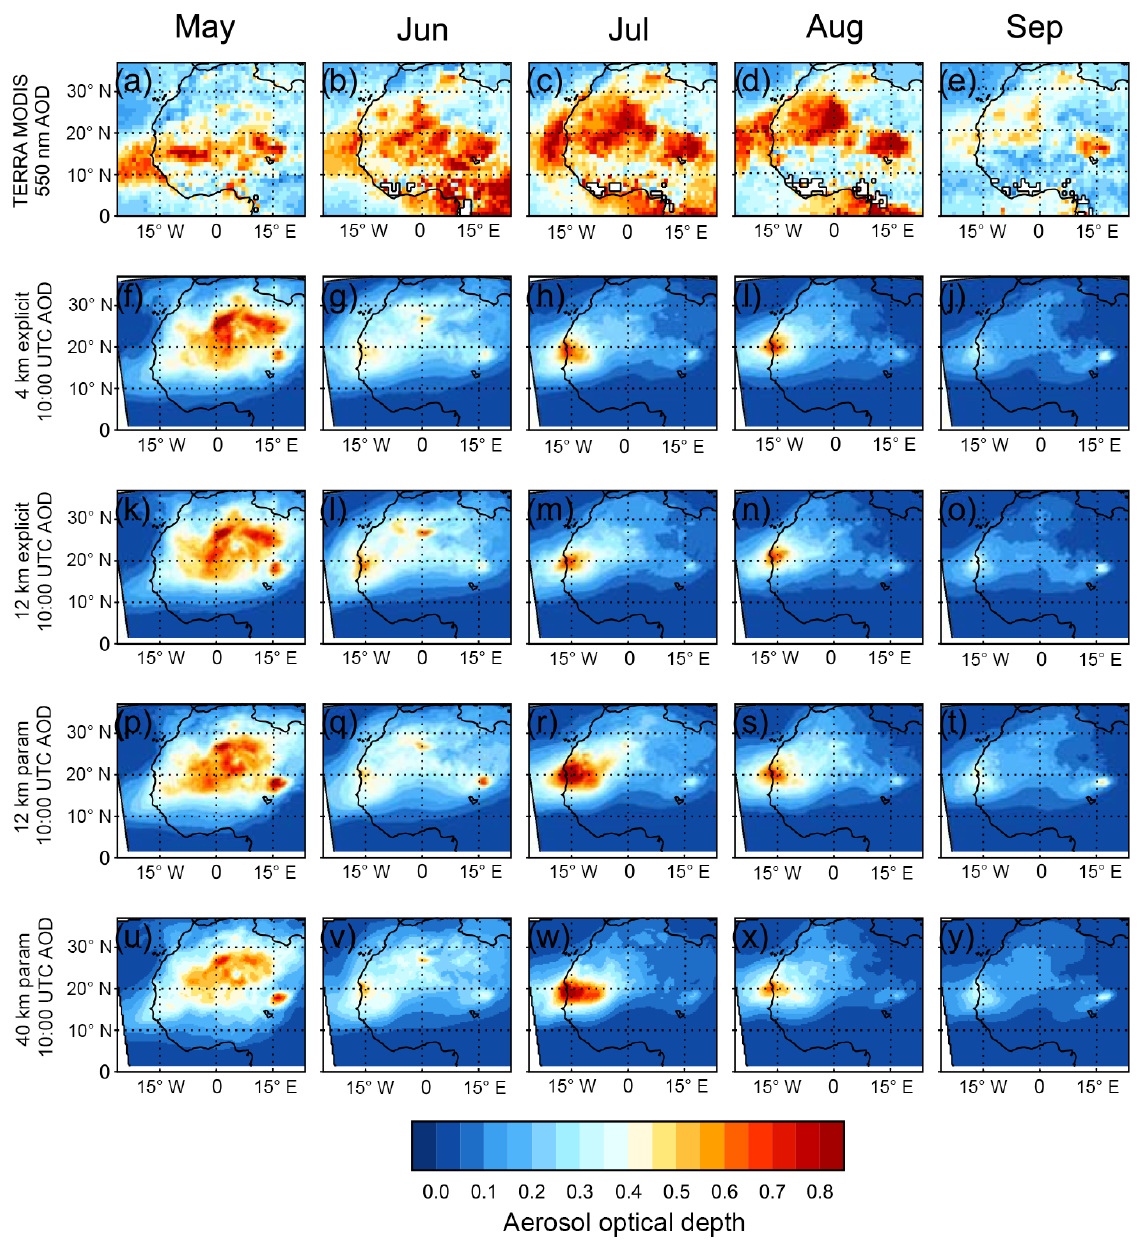
Figure 2. Monthly mean (May–September, left-right) aerosol optical depths (AODs) at 10:00UTC from (a–e) , MODIS Terra satellite (com- bined deep blue and land–ocean data sets), (f–j) 4km simulation with explicit convection (4E), (k–o) 12km simulation with explicit convec- tion (12E), (p–t) 12km simulation with parameterised convection (12P) and (u–y) 40km simulation with parameterised convection (40P). Simulations have been subsampled temporally to the TERRA MODIS overpass time to allow for a reduction in differences introduced through the diurnal